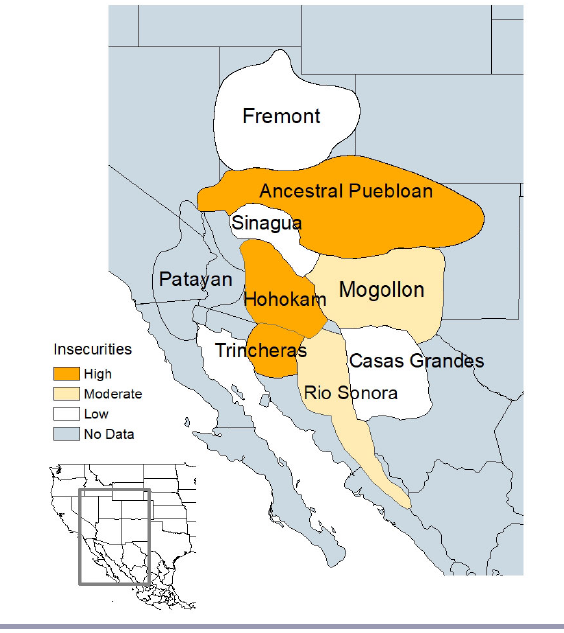
Fig. 2 . Economic insecurity prior to depopulation (indicator: decreasing trade and exchange).